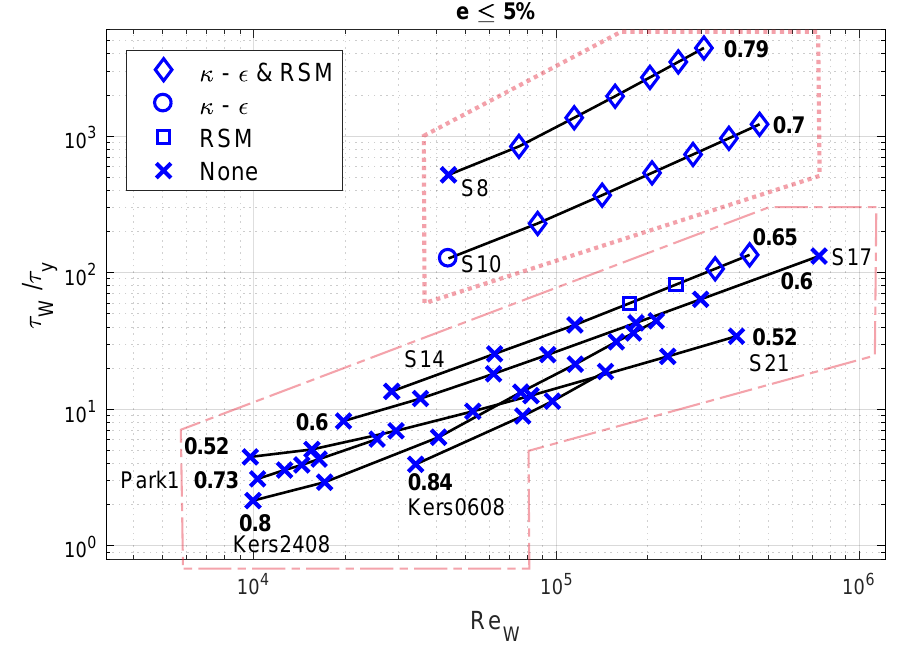
Figure 13. Performance of the standard RANS models to achieve an error e ≤